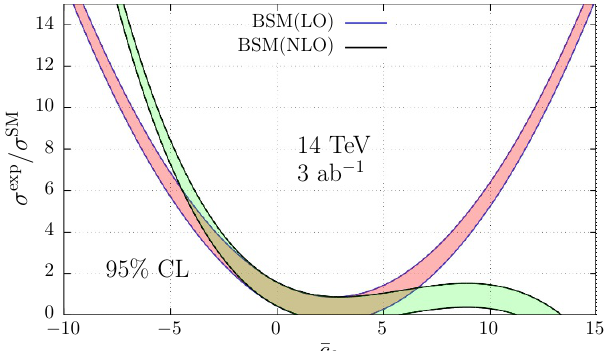
Figure 12 . Bounds on (cid:22) c 6 that can be set according to the supposedly double-Higgs measured cross section, normalised to the corresponding SM prediction. The red band is obtained considering only (cid:27) LO , while the green using (cid:27) pheno NLO